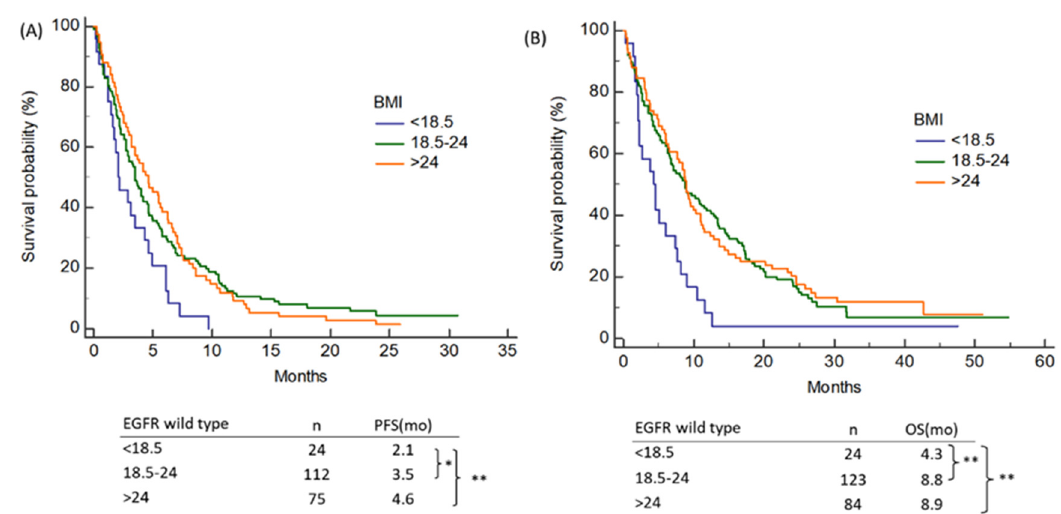
Figure 3. Influence of the baseline BMI on ( A ) PFS and ( B ) OS of NSCLC patients with wild-type EGFR status. BMI—body mass index; PFS—progression-free survival; OS—overall survival; NSCLC—non-small cell lung cancer; EGFR—epidermal growth factor receptor; Note: * p < 0.05, ** p < 0.001.